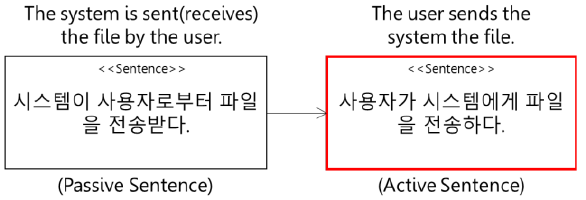
Figure 5. AND conjunction relationship.